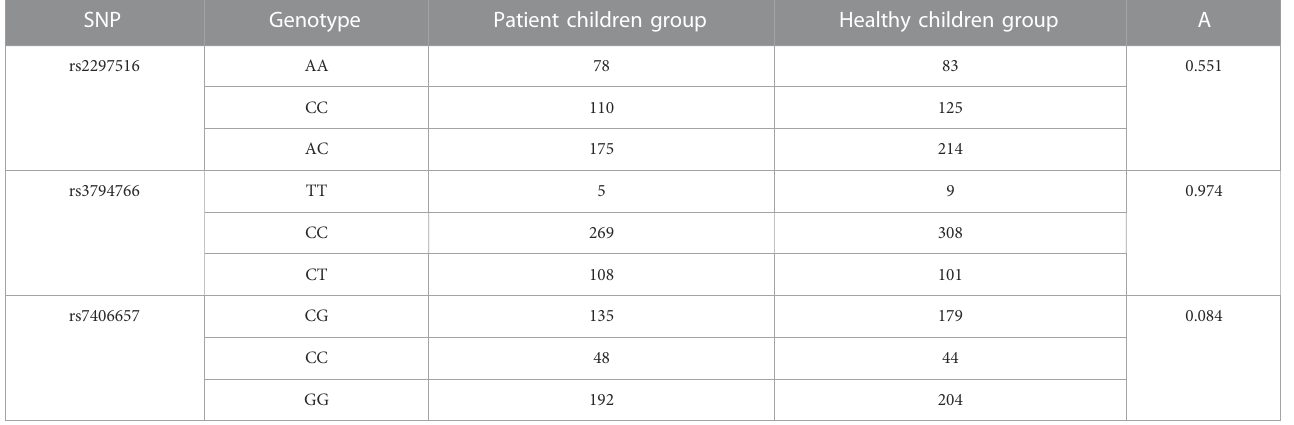
TABLE 2 Difference of distribution of NOS2 gene SNP genotype between patient children group and healthy children group.